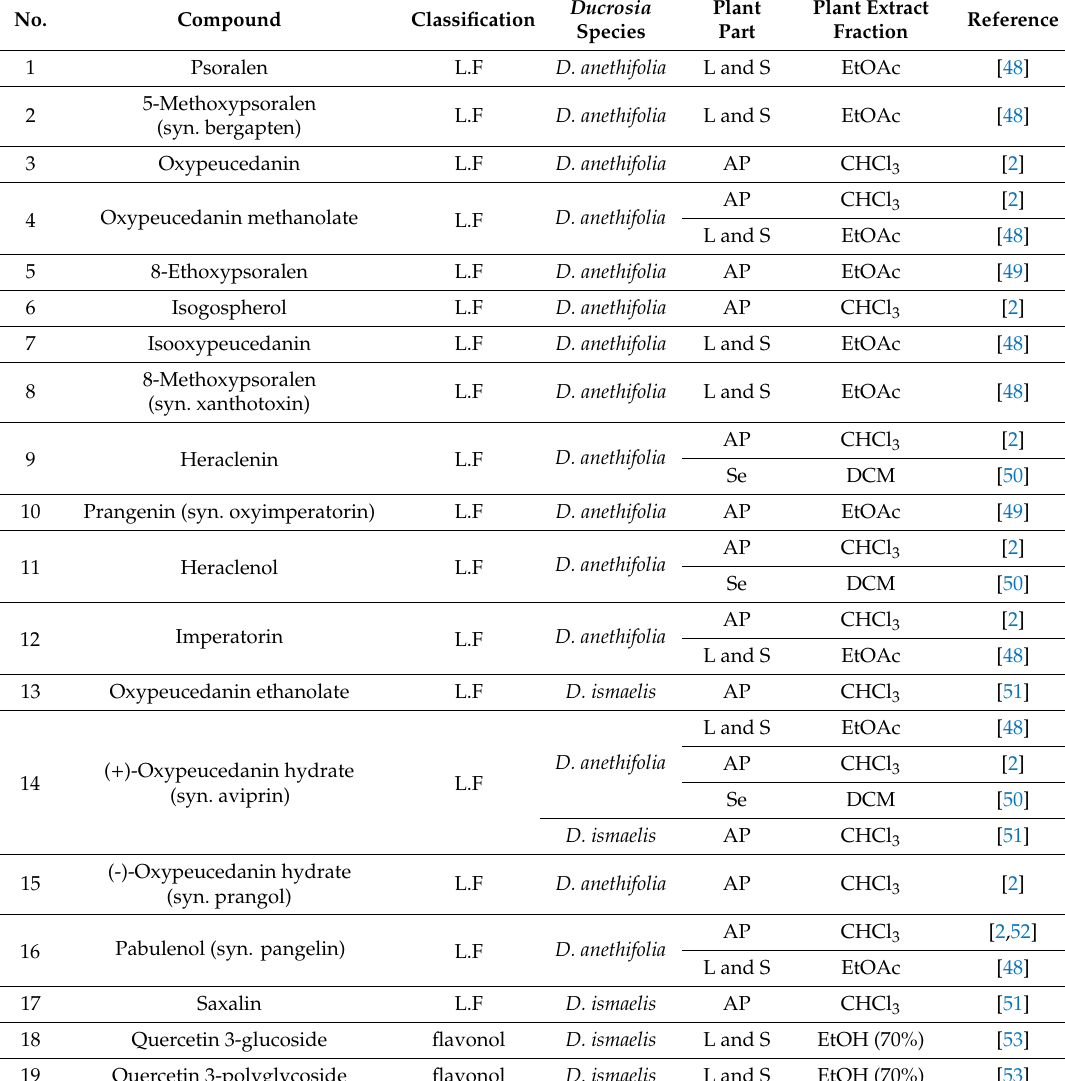
Table 2. The non-volatile phytoconstituents identified from Ducrosia